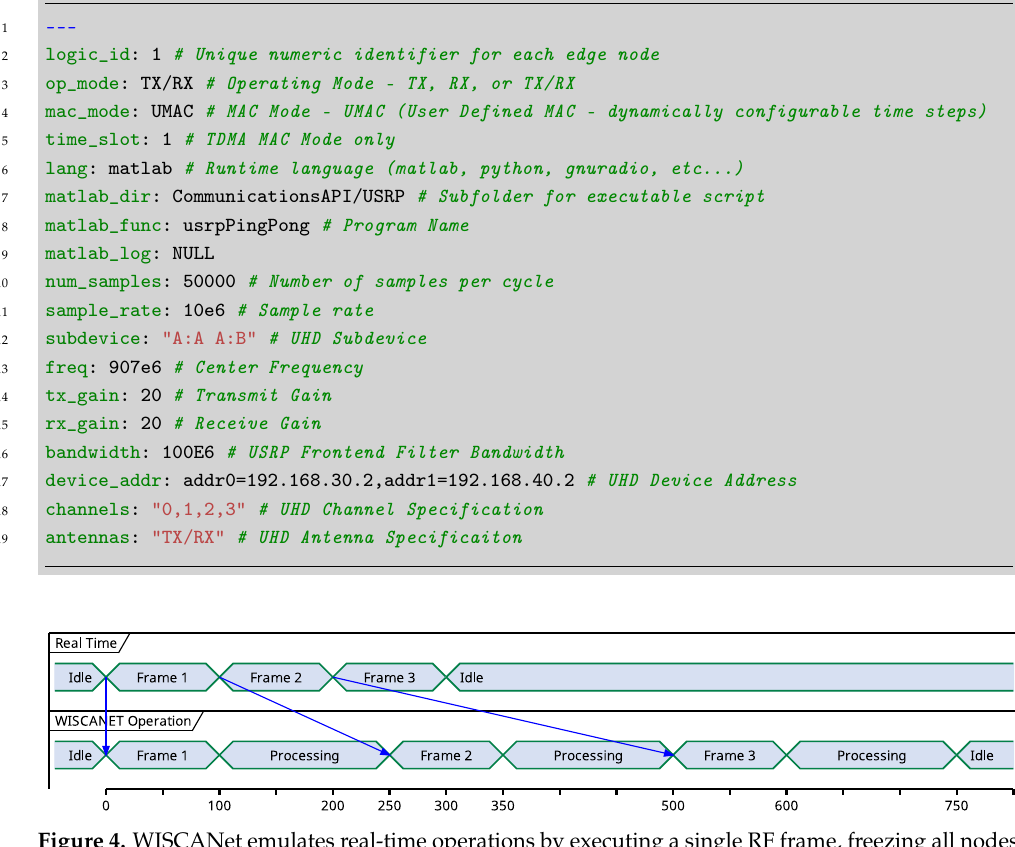
Figure 4. WISCANet emulates real-time operations by executing a single RF frame, freezing all nodes’ transmit and receive operations, performing baseband processing in MATLAB (or other compatible language), and resuming all RF operations on the edge nodes at the same time for the next frame. From the radios’ perspectives, this application looks real-time; but the extra processing time allows users to test minimally-viable code without needing to optimize and accelerate it (traditionally a tedious and time-consuming process). This also allows WISCANet to support languages like MATLAB that are traditionally slower than more optimal